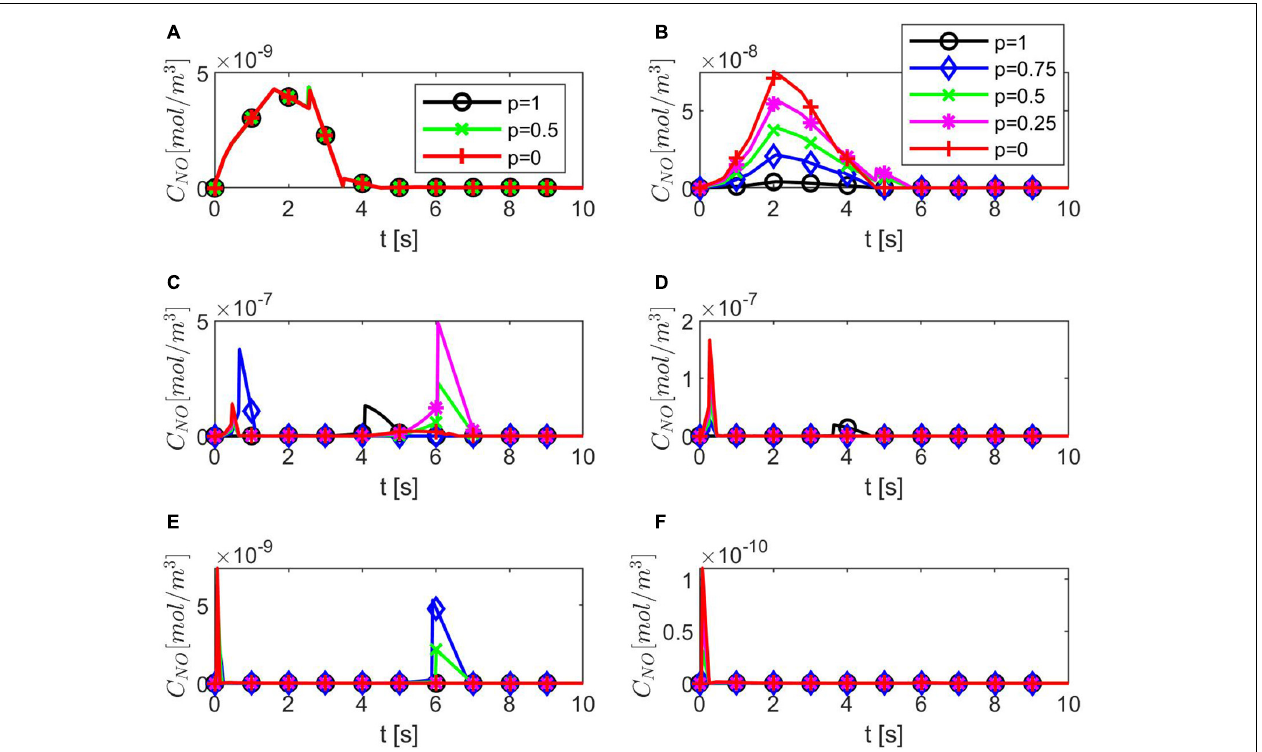
FIGURE 4 | Temporal profiles of C NO at r = a + h , the outer boundary of the endothelium, for (A) ε = 1 , (B) ε = 0 . 95 , (C) ε = 0 . 85 , (D) ε = 0 . 75 , (E) ε = 0 . 5 , and (F) ε = 0 . 25 and various values for p and q = 1 − p ( B–F have the same legend shown in B ). Here E = 6 × 10 3 N / m , γ = 0 . 75 , ˜ λ = 6 . 5325 × 10 3 s − 1 .